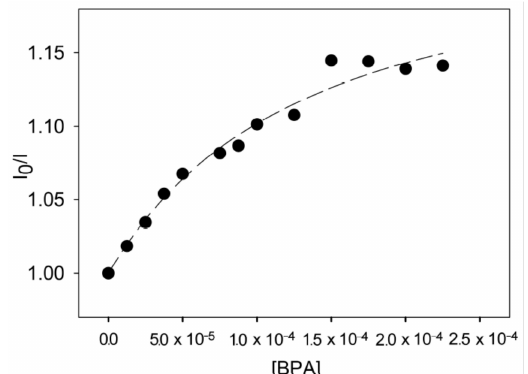
Figure 14. Calibration curve for different BPA concentration obtained by using the ratio of lumines- cence intensity of the [Ru (phen)2 L]2+ complex over luminescence intensity of the complex upon addition of increasing concentration. (Reprinted from [80] under Open Access